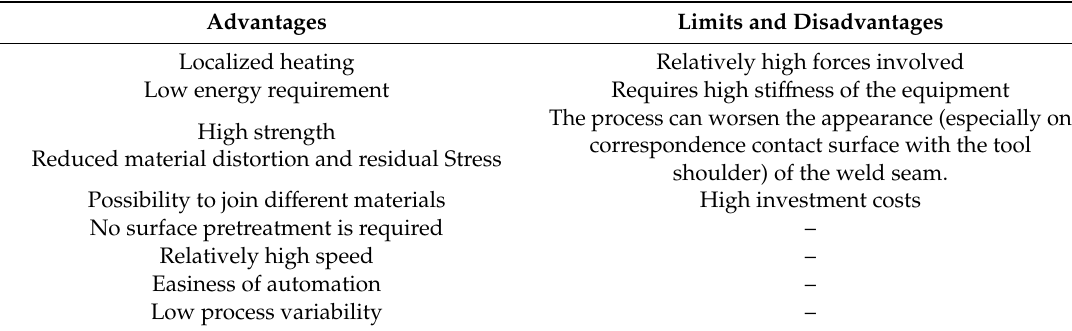
Table 3. Pro and cons of friction stir welding and friction spot stir welding.